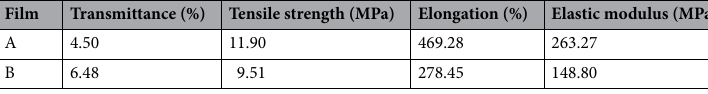
Table 2. Properties of mulching films.